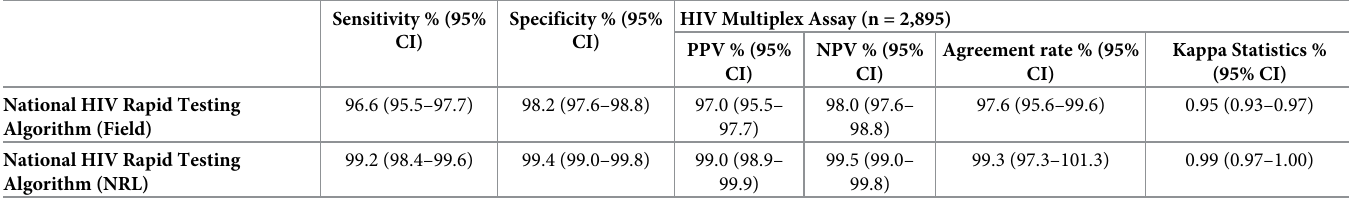
Table 5. The comparison of the national serial HIV rapid testing algorithm performed at the field and NRL with HIV multiplex assays from the prospective study.